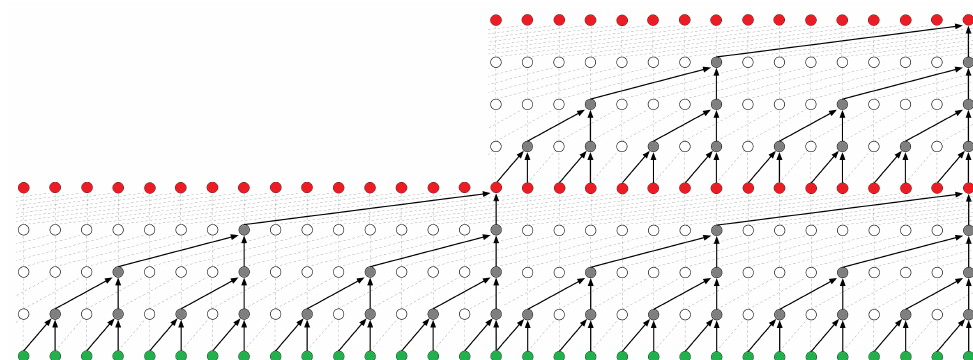
Figure 6. Visual illustration of a causal TCN with stacked blocks [62]. This TCN has a block size of 2, a dilation list (1,2,4,8) (i.e., dilation factor 8), and a kernel size of 2. This results in a receptive field of 2 · 2 · 8 = 32.